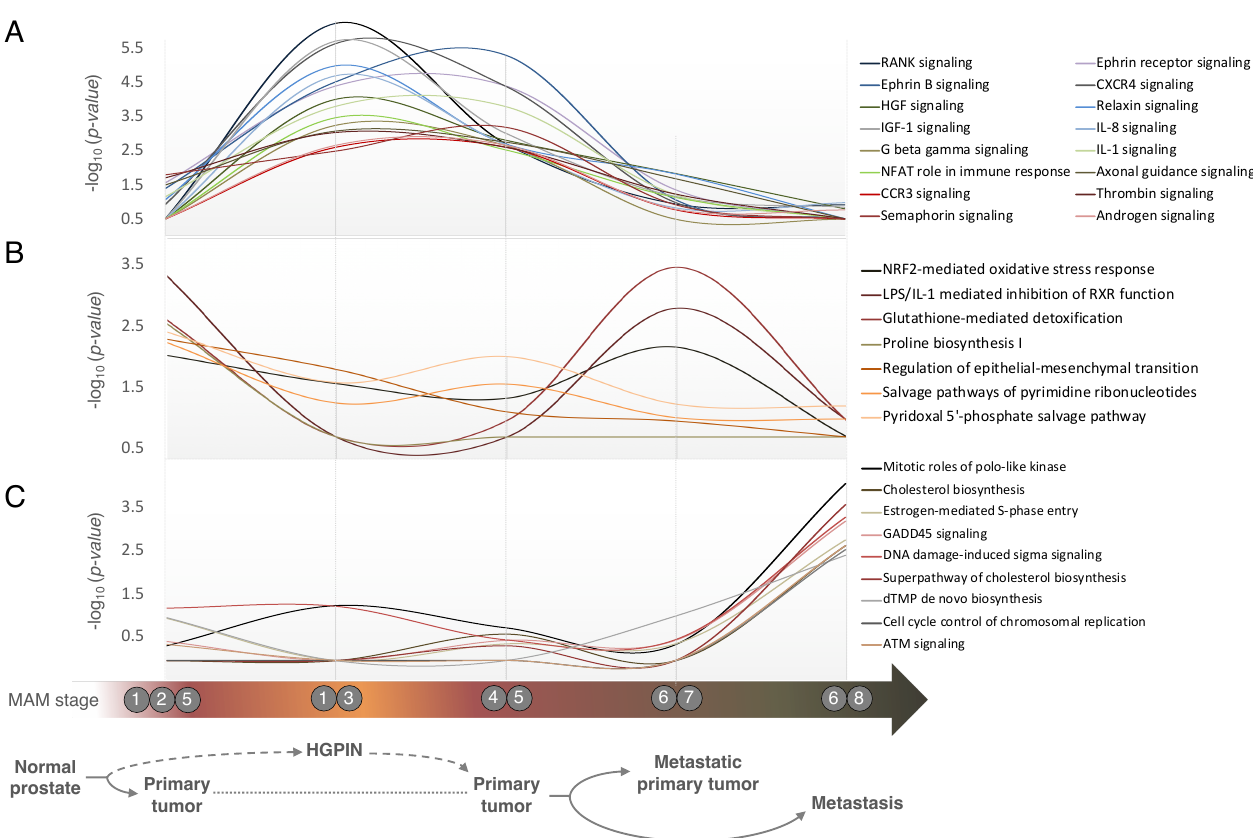
Figure 5. Pathways enriched at distinct stages of disease development and progression. Enrichment patterns across PC development and progression stages for selected pathways significantly associated with ( A ) HGPIN, ( B ) primary and ( C ) metastatic disease ( p -value < 0.01). Corresponding MAM stages (x-axis) are denoted by circled numbers under the plots. The pathways enrichment is based on IPA p -values (Fisher’s exact test) presented in -log 10 scale